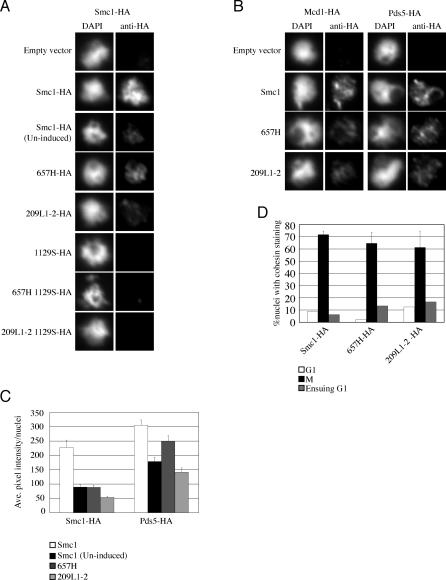

Smc1 RID Mutants 657H and 209L1–2 Bind Chromosomes as Subunits of Cohesion(A and B) Minichromosomes with the different Smc1 alleles were introduced into YMM10 (smc1–2), YMM11 (smc1–2 MCD1-6HA), or YMM20 (smc1–2 PDS5-6HA). Cultures of these cells were released from a G1 arrest into media that supported either the induced or uninduced expression of the Smc1 alleles, inactivated smc1–2, and caused arrest in mitosis (see Materials and Methods). Nuclei from mitotic arrested cultures were spread on slides and processed for immunofluorescence. The micrographs show representatives images of chromosomes (DAPI) and the chromosome staining of the different Smc1 proteins, Mcd1-6HA, and Pds5-6HA (anti-HA). The allele of SMC1 expressed from the minichromosome is listed on the left.(C) The chromosome association of Smc1-HA and Pds5-6HA was quantitated by determining the average pixel intensity per nuclei following staining for Smc1-HA and Pds5-6HA (see Materials and Methods).(D) Nuclear spreads were prepared as described above, except half of the cells released from G1 were arrested in mitosis while the other half were arrested in the ensuing G1 (see Materials and Methods). Nuclear spreads were prepared from aliquots of the original G1-arrested cells and those arrested in mitosis and the ensuing G1. The percent of nuclei with chromosomal staining of Smc1-HA, 657-HA, and 209L1–2-HA was determined.